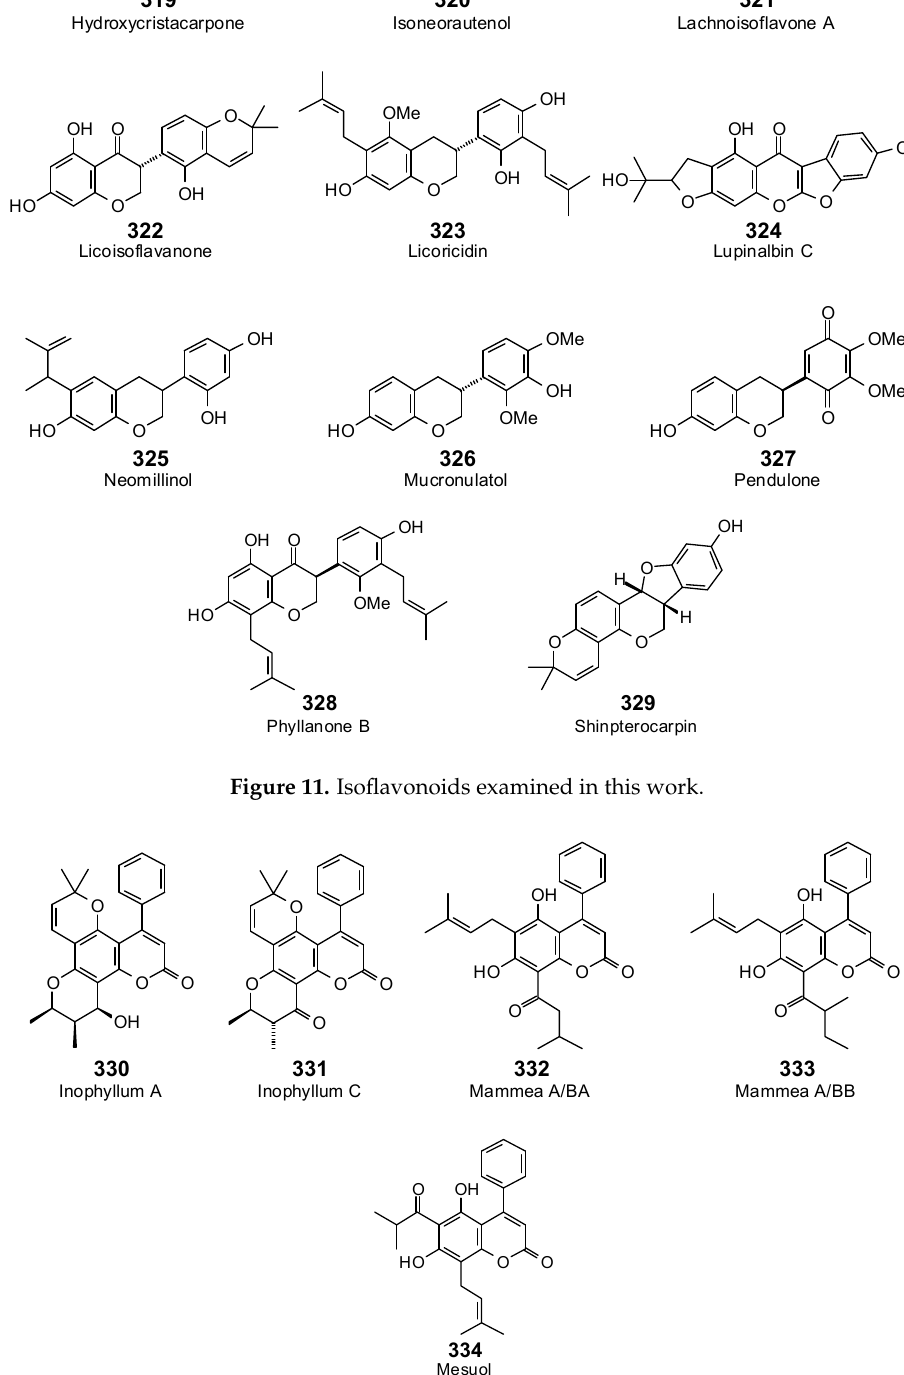
Figure 12. Neoflavonoids examined in this work.